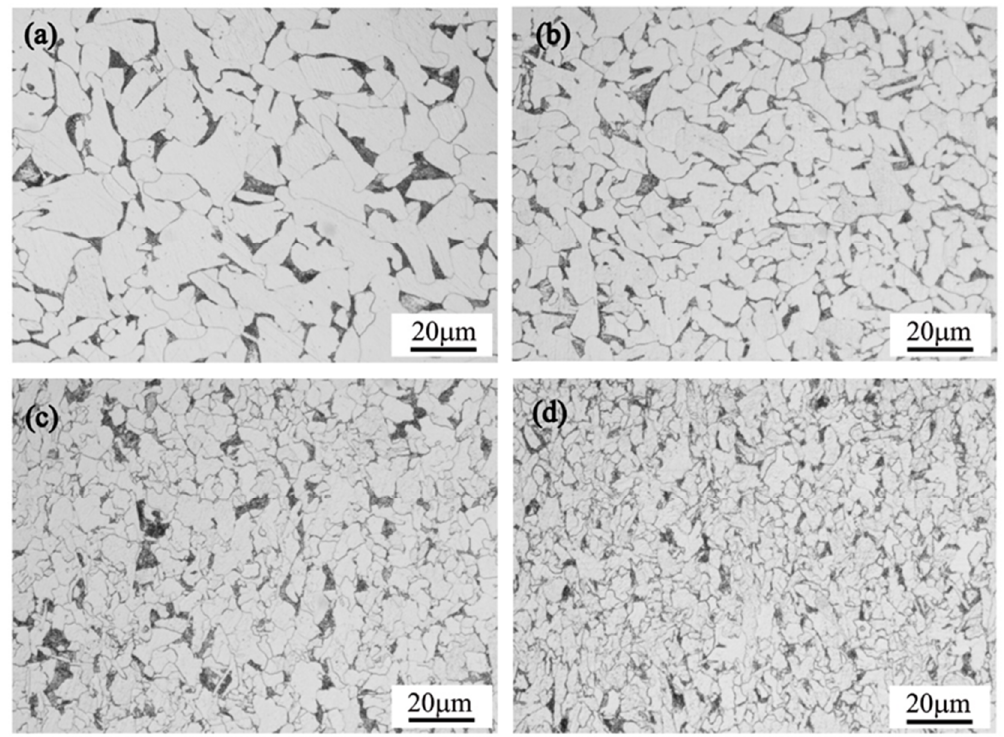
Figure 9. Microstructure of as-rolled steels ( a ) Q235B ( b ) Q235BM ( c ) Q355B ( d ) Q355BM.